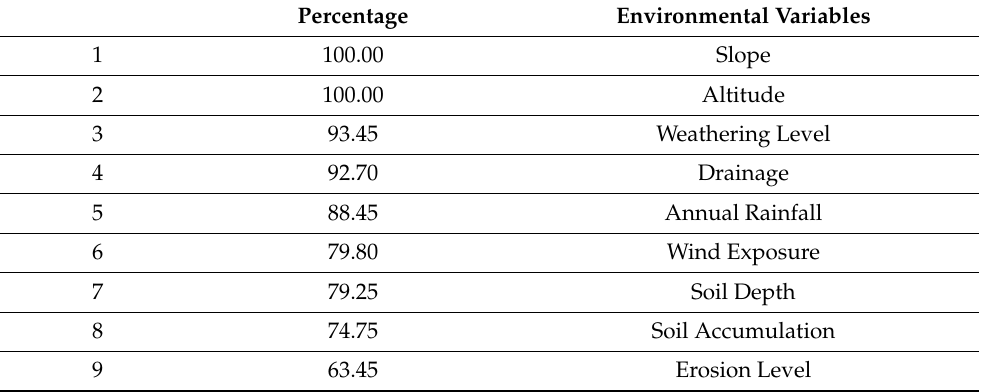
Table 6. Attribute usage after the